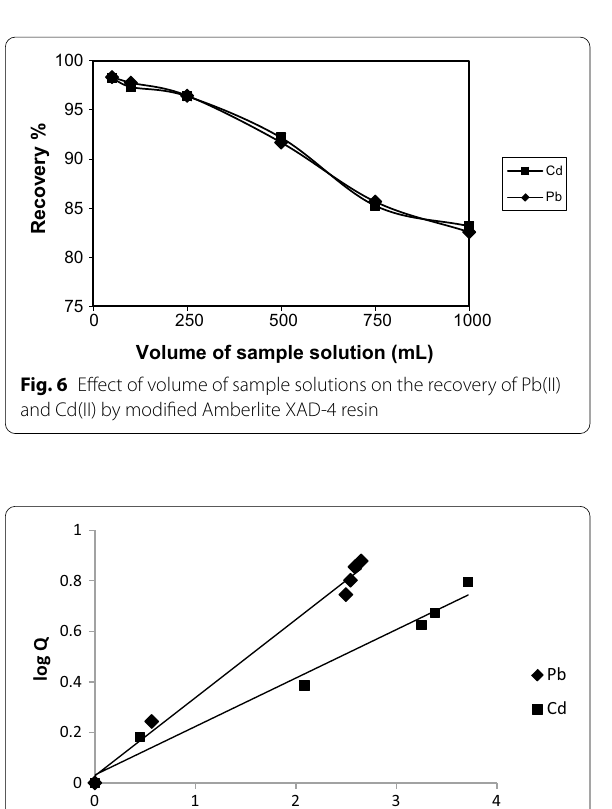
Fig. 7 Freundlich sorption isotherms of Pb(II) and Cd(II) ions by modified Amberlite XAD-4 resin